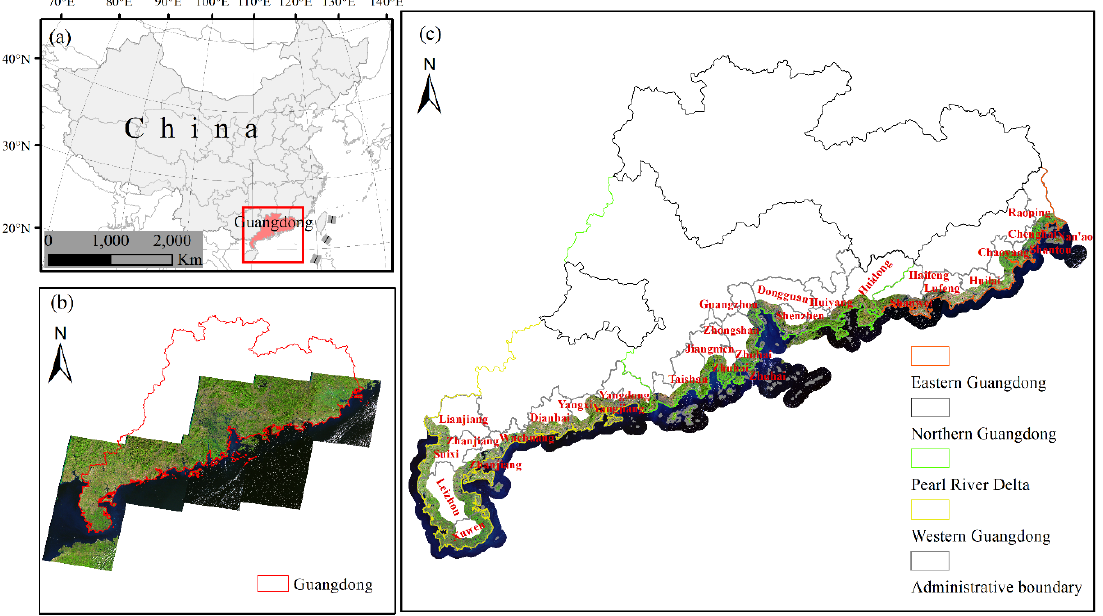
Figure 1. ( a ) Location of Guangdong province; ( b ) mosaic image (R, G, B = 5, 4, 3) covering coastal Guangdong collected in 1985; ( c ) subset image (R, G, B = 5, 4, 3) covering the study area in 1985, with the overlay of municipal administrative